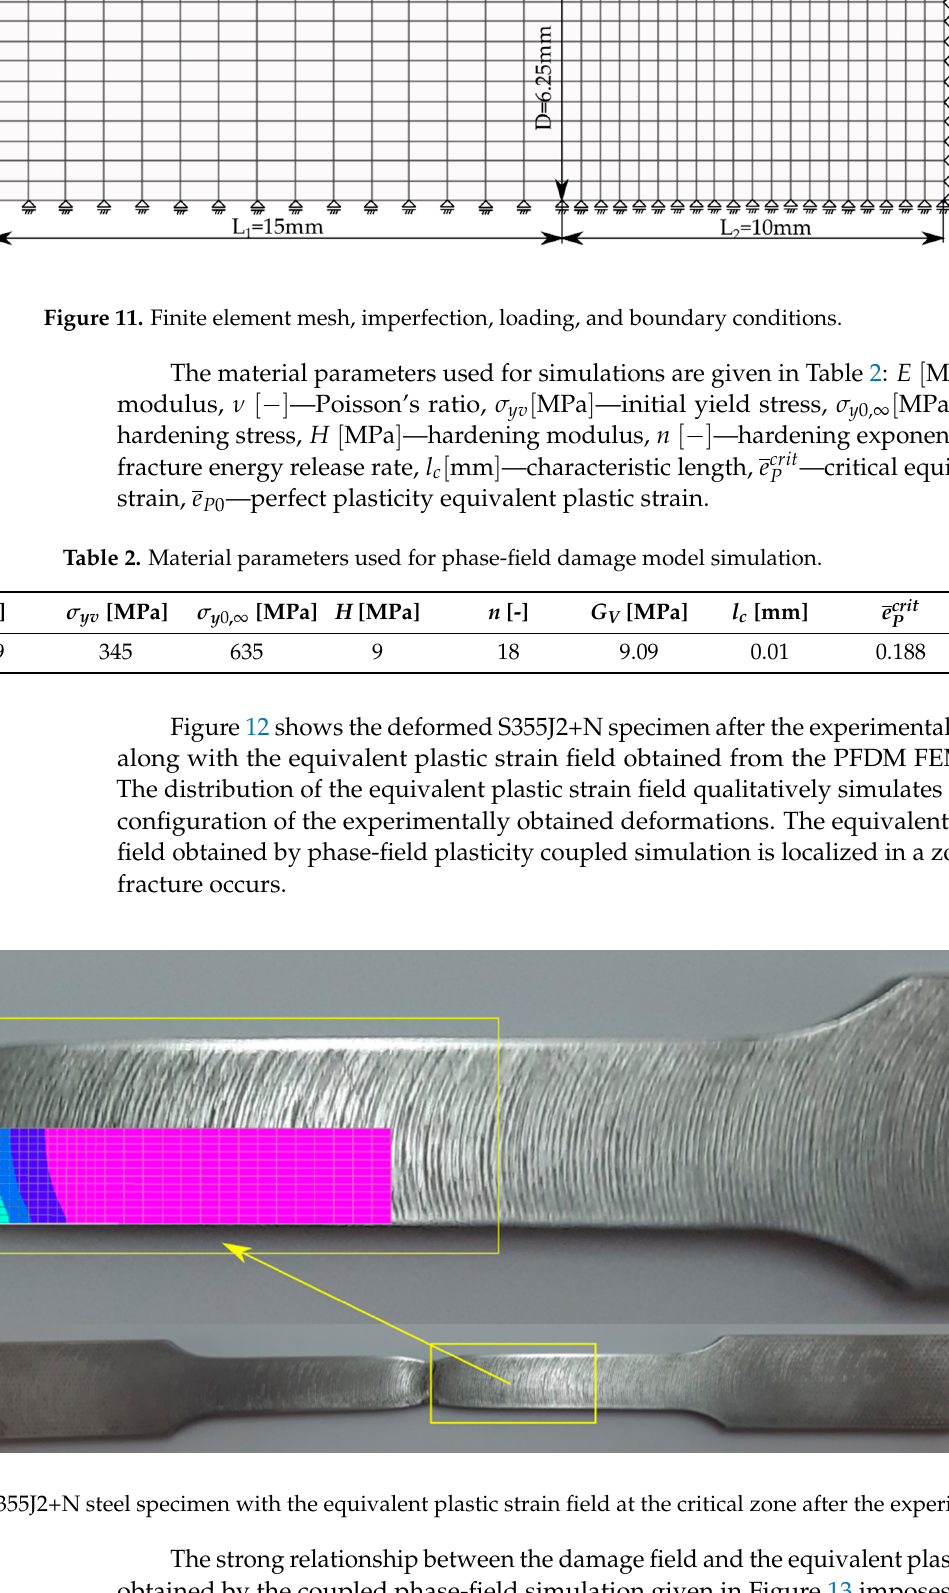
Figure 11. Finite element mesh, imperfection, loading, and boundary conditions.